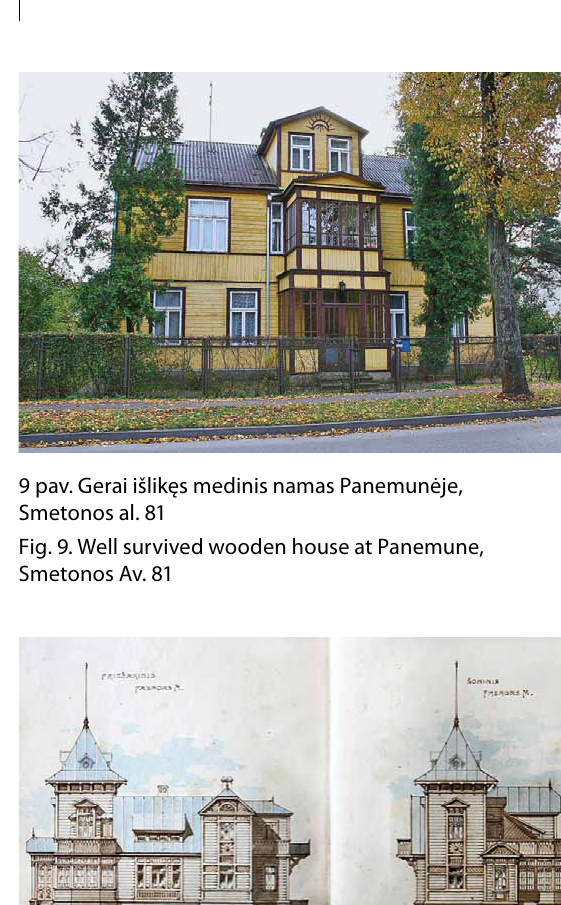
fig. 10. a draft of Daugvila’s family house at Kauko av.